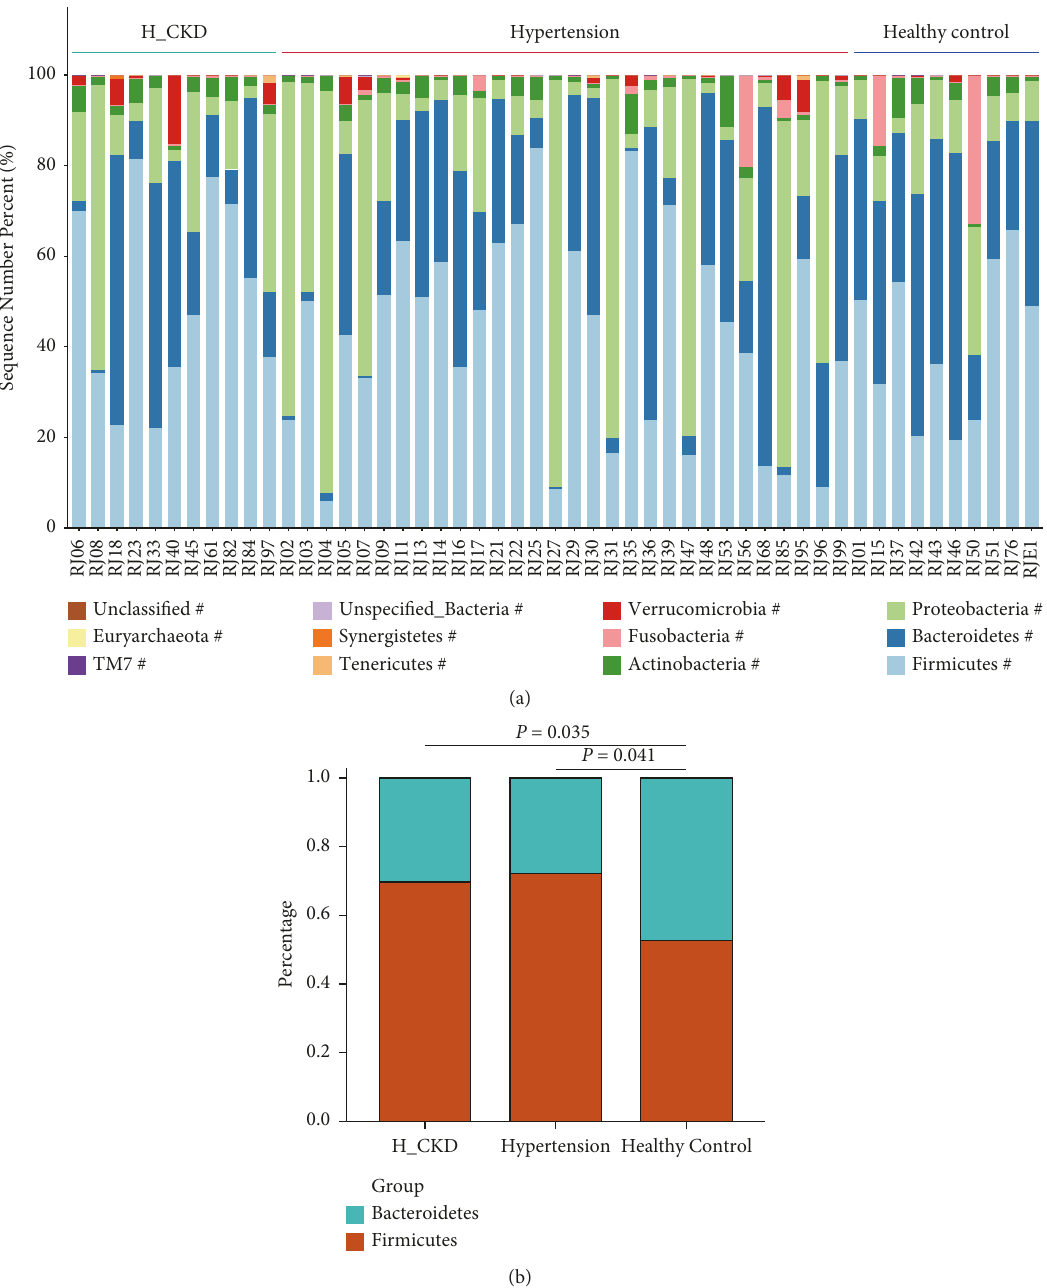
Figure 2: Variations of fecal microbiota in H-CKD, hypertension and healthy control. (a) Relative proportions of bacterial phyla in H-CKD ( n 11), hypertension ( n 30), and healthy control ( n 10); different colors represent different phyla; It suggests biodiversity in every (cid:31) (cid:31) (cid:31) individual; no significant different phylum was found among the three groups (#: p 0 . 05); (b) rate of relative proportions of F/B. F/B in both H-CKD and hypertensive is significantly lower than it in Healthy Control group. F/B: >